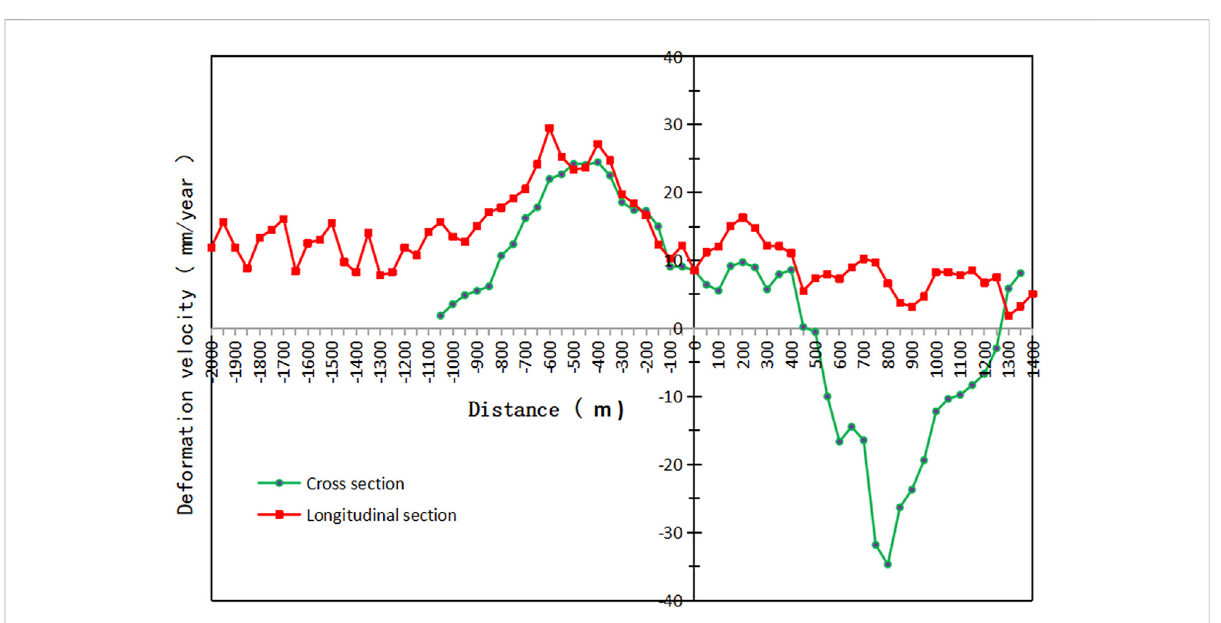
FIGURE 6 Longitudinal section and cross section deformation